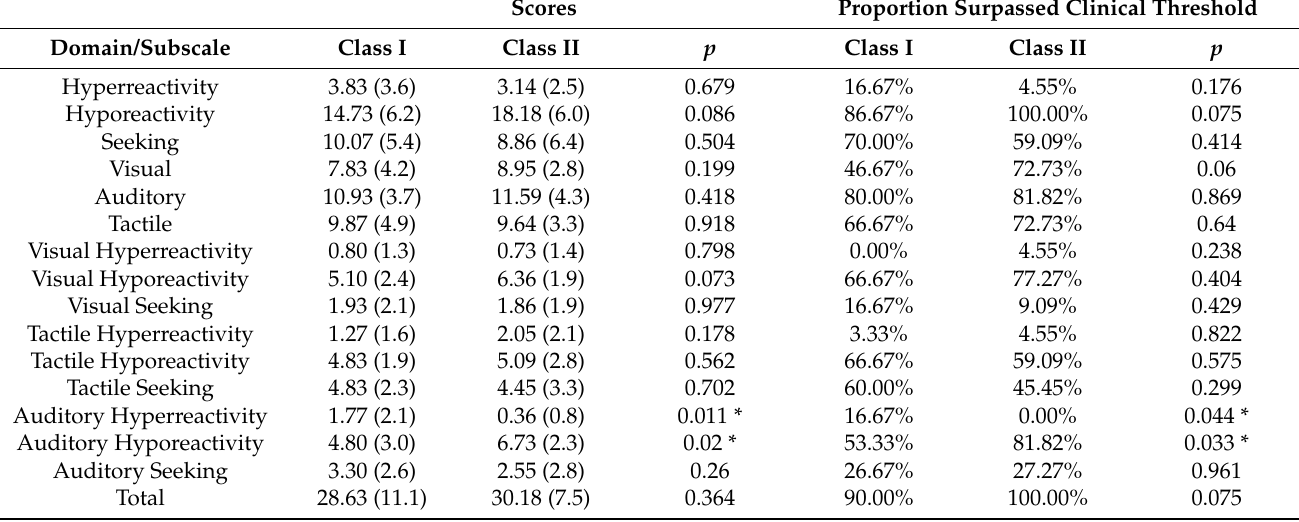
Table 5. Genotype–phenotype associations. Mean and standard deviation displayed for SAND scores followed by proportion of participants who surpassed the clinically significant threshold on the SAND for each domain and subscale. * indicates a statistically significant